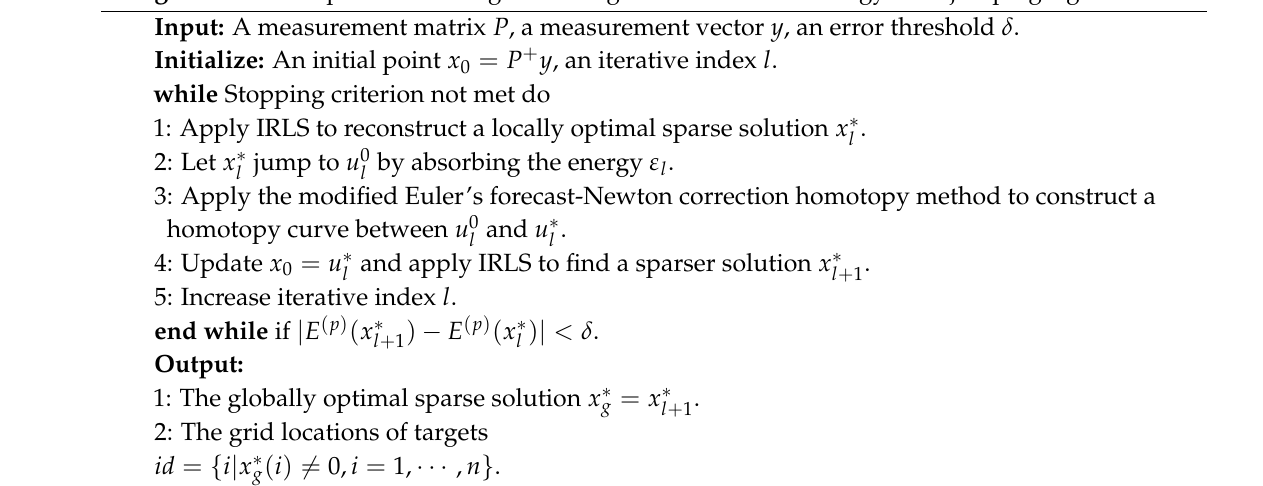
Algorithm 1: Compressive sensing-based target localization via energy-level jumping